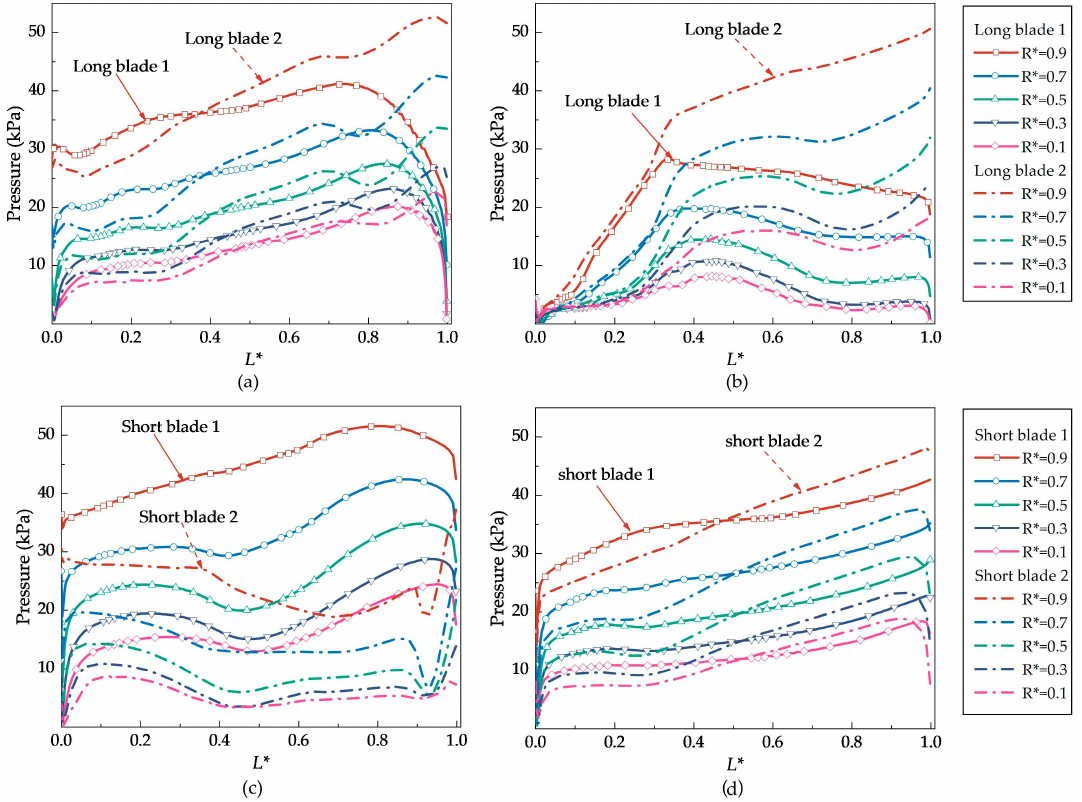
Figure 9. Blade load at different R *: ( a ) Long blade pressure surface; ( b ) Long blade suction surface; ( c ) Short blade pressure surface; ( d ) Short blade suction